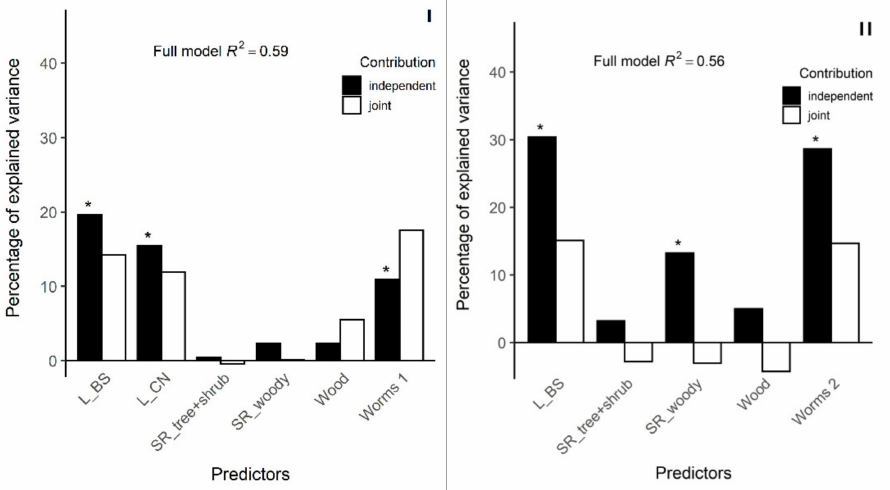
Figure 5. Hierarchical partitioning for ( I ) soil carbon stocks in the organic horizon (FH-layer) and ( II ) soil carbon stocks in in the 50-cm mineral layers. Independent variables: L_BS—base saturation in litter layer; L_CN—C:N ratio in litter layer; SR_tree + shrub—total species richness in shrub and tree layers; SR_woody—species richness of woody plants in herb layer; Wood—stem wood stock; Worms1—functional groups of earthworms associated with the organic horizon; Worms2—functional groups of earthworms associated with soil mineral horizons; asterisks indicate the significance: *— p ≤